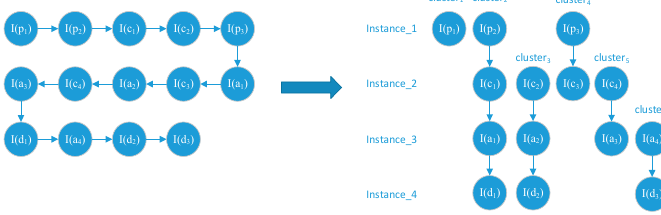
Figure 4. The alert instance clusters construction.